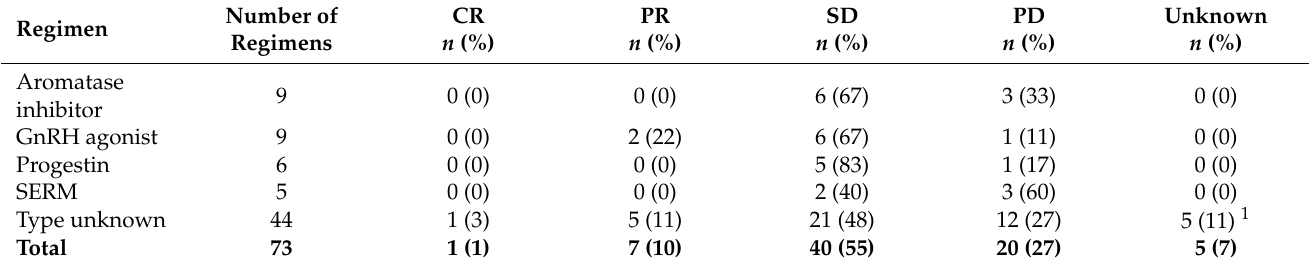
Table 6. Summary of response rates of anti-hormonal therapy for aGCT, excluding case